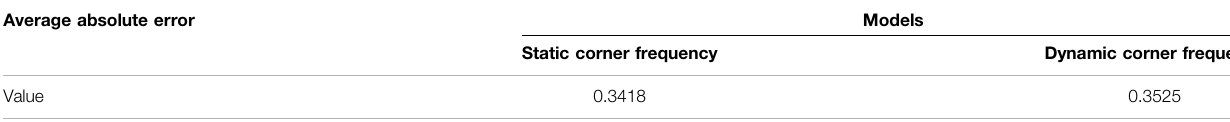
TABLE 7 | The average absolute error for the two